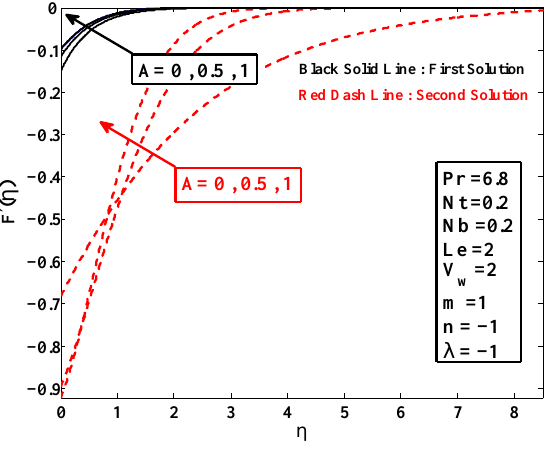
Figure 8: First and second solutions of velocity profile f (cid:48) ( η ) for differ- ent values of unsteadiness parameter A